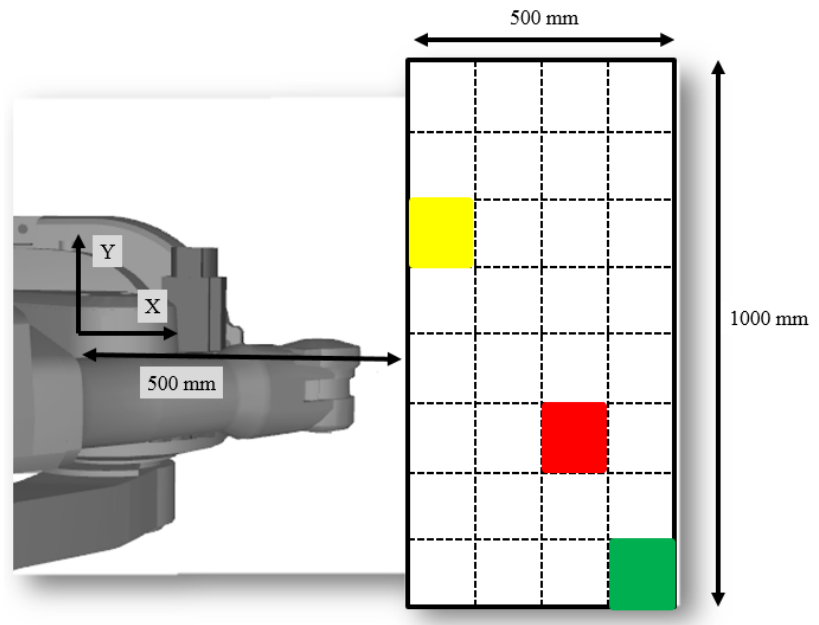
Figure 4. Top view image from the 2D workspace: start in yellow, obstacle in red, target in green, which are all placed arbitrarily.